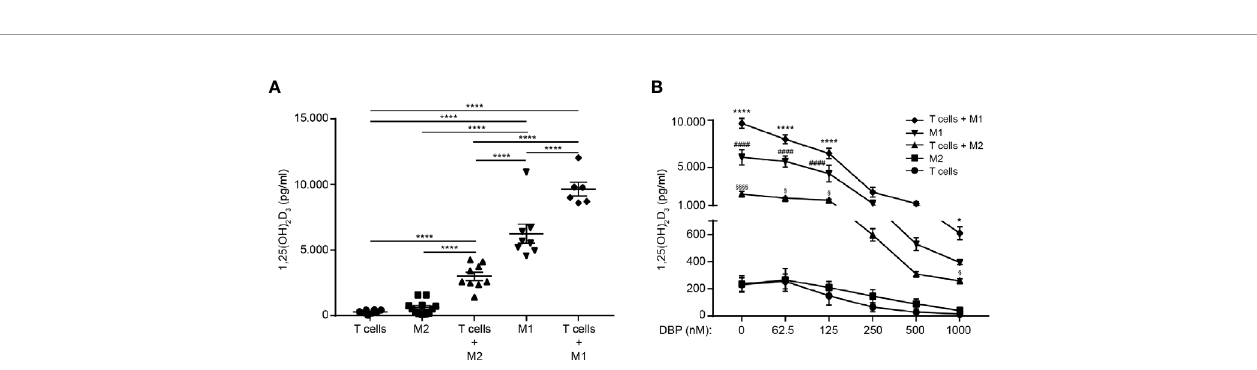
FIGURE 3 | T cells enhance the production of 1,25(OH) 2 D 3 in M1 and M2 macrophages. (A) Production of 1,25(OH) 2 D 3 in mono-cultures of activated CD4 + T cells, M1 and M2 macrophages and in co-cultures of CD4 + T cells and M1 and M2 macrophages cultured in the presence of 100 nM 25(OH)D 3 for 96 hours. Data (mean ± SEM) were obtained from fi ve independent experiments with 12 donors (8 T cells donors 6 M1 macrophage donors, 12 M2 macrophage donors, 6 donor pairs for T cells in co-culture with M1 macrophages (2 T cell donors and 3 M1 macrophage donors mixed to 6 combinations) and 9 donor pairs for T cells in co-culture with M2 macrophages (3 T cell donors and 3 M2 macrophage donors mixed to 9 combinations) and were tested by use of one-way ANOVA with post hoc multiple comparisons test (Tukey ’ s). (B) Production of 1,25(OH) 2 D 3 in mono-cultures of activated CD4 + T cells, M1 and M2 macrophages and in co-cultures of CD4 + T cells and M1 and M2 macrophages cultured in the presence of 100 nM 25(OH)D 3 and DBP at the indicated concentrations for 96 hours. Data (mean ± SEM) were obtained from three independent experiments with 8 donors (7 T cells donors 3 M1 macrophage donors, 6 M2 macrophage donors, 6 donor pairs for T cells in co-culture with M1 macrophages (2 T cell donors and 3 M1 macrophage donors mixed to 6 combinations) and 4 donor pairs for T cells in co-culture with M2 macrophages (2 T cell donors and 2 M2 macrophage donors mixed to 4 combinations) and were tested by use of two-way ANOVA with post hoc multiple comparisons test (Tukey ’ s). *T cells + M1 macrophages versus M1 macrophages; # M1 macrophages versus T cells + M2 macrophages; $ T cells + M2 macrophages versus M2